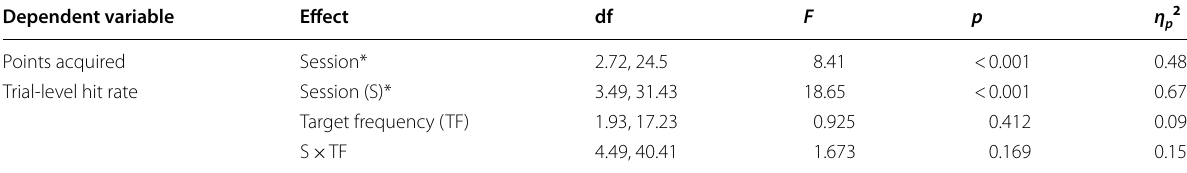
Table 1 Results of analyses on raw value accuracy